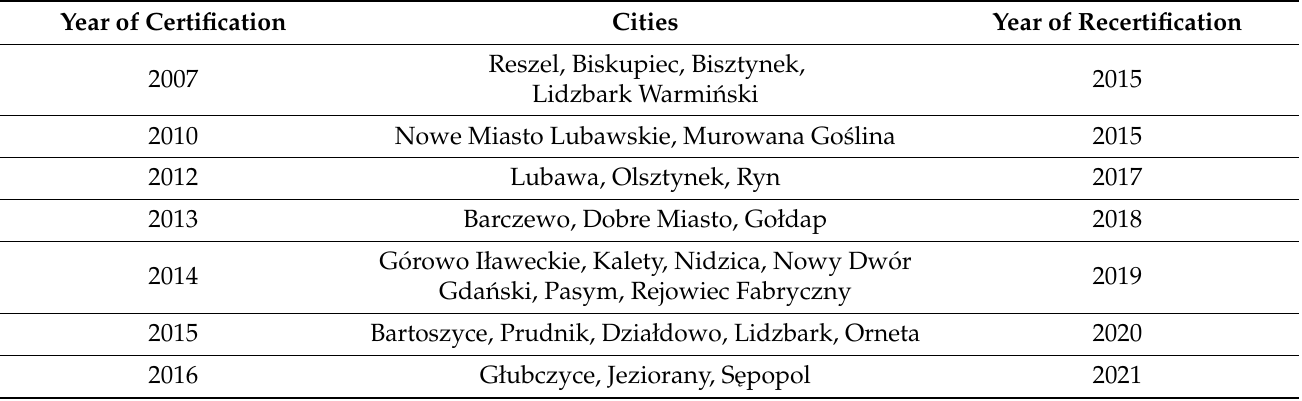
Table 3. The Polish Cittaslow network member cities which have passed the recertification